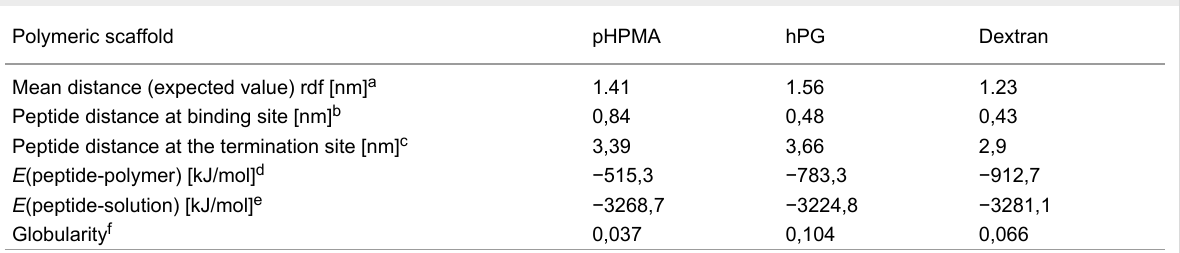
Table 2: Molecular dynamics simulations of the protein target and the multivalent polymeric ligands. Polymeric